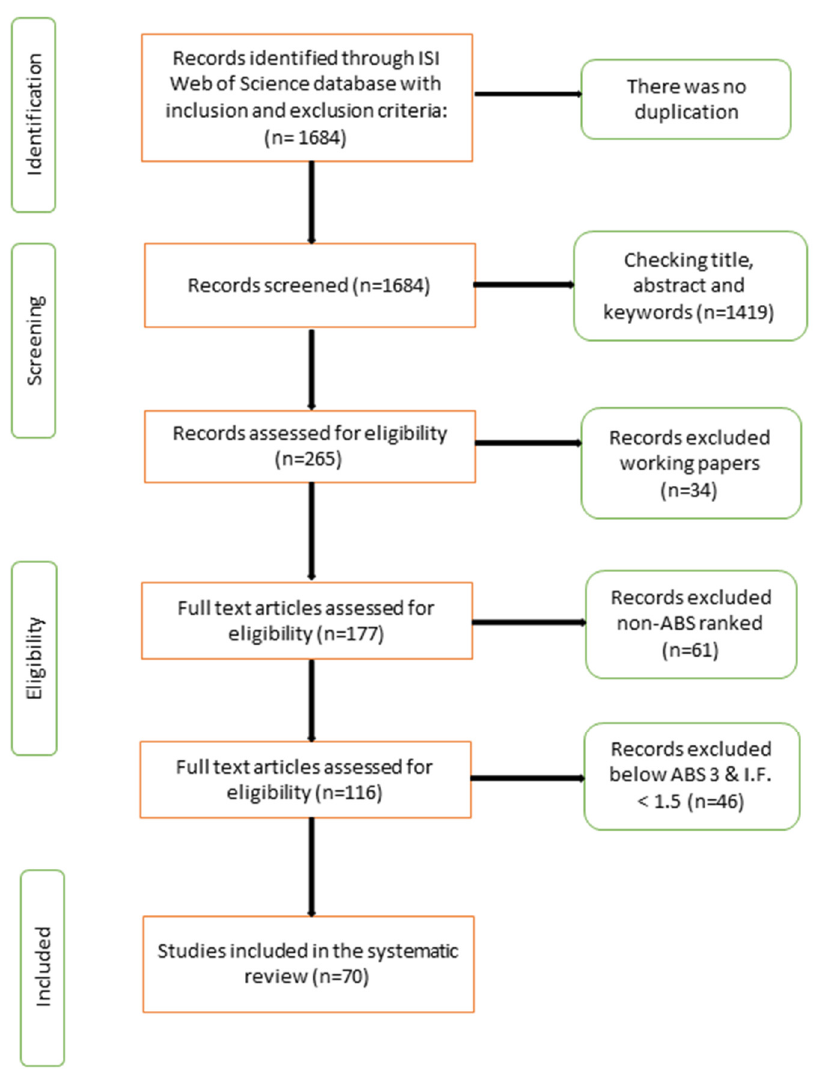
Figure 2. Flowchart of the study selection process regarding relevance and quality of the initially selected